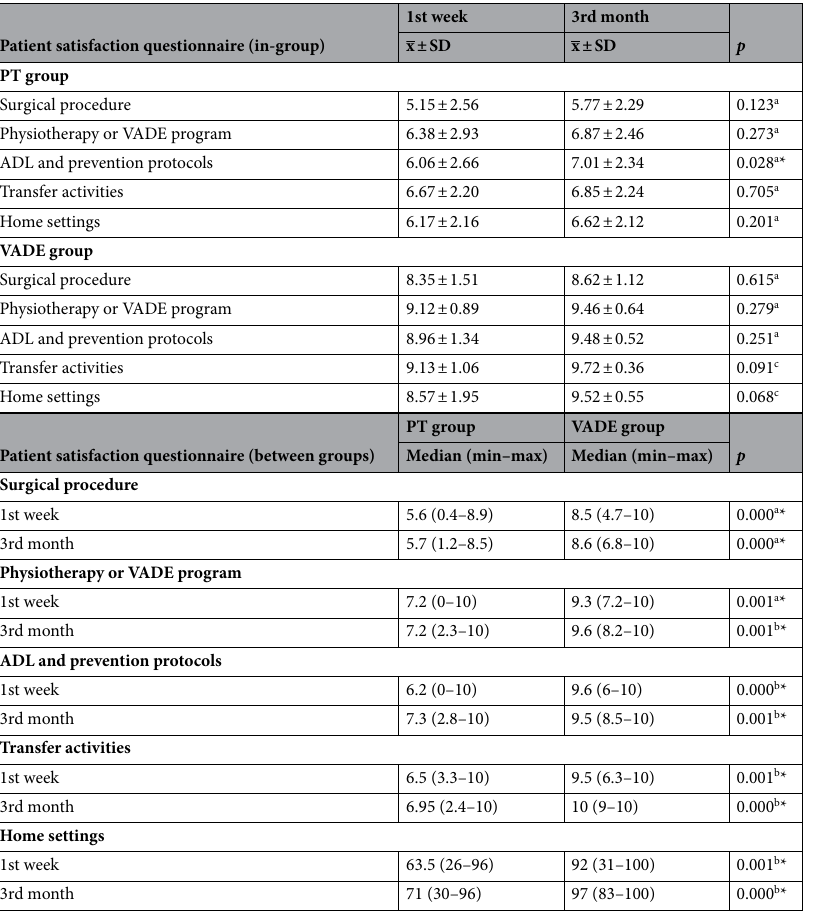
Table 4. Comparison of patient satisfaction levels. PT physiotherapy, VADE video-assisted discharge education, min minimum, max maximum, ADL activities of daily living, * p < 0.05 statistically